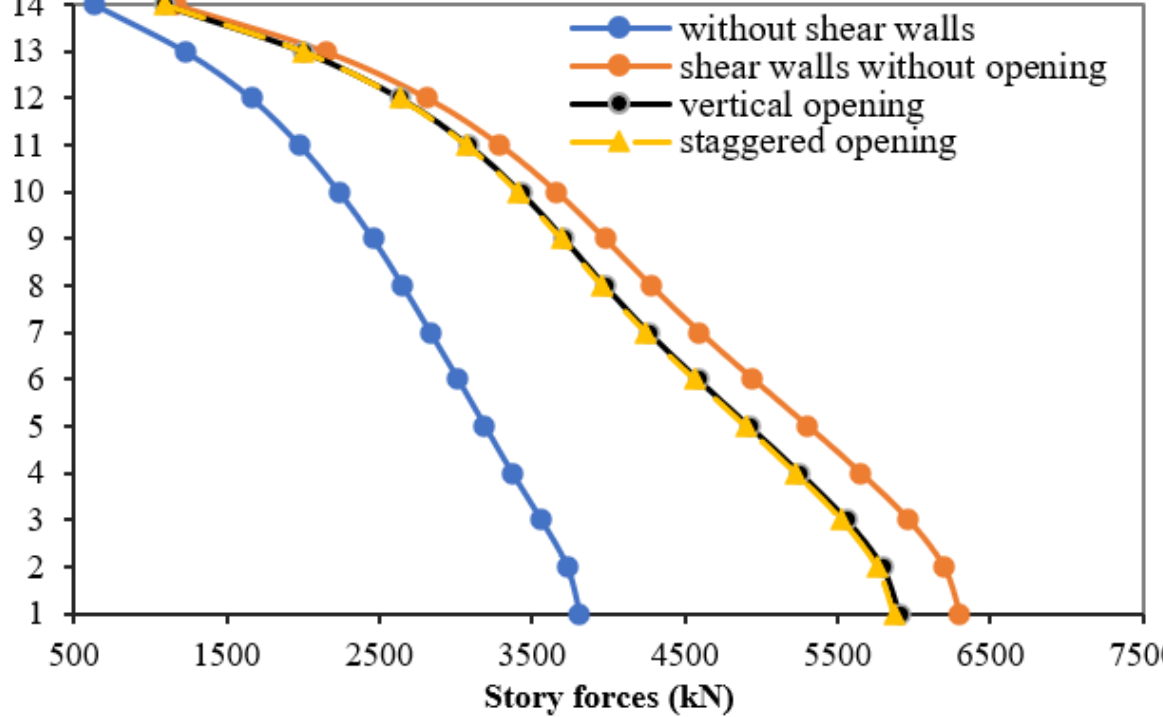
Figure 19. Story forces of the models, response spectrum analysis, X-direction.